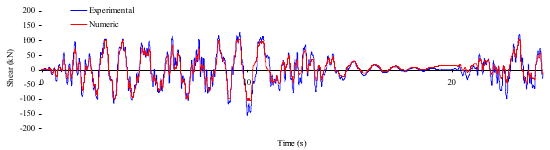
Figure 12. Column shear evolution considering only bending behav- ior.